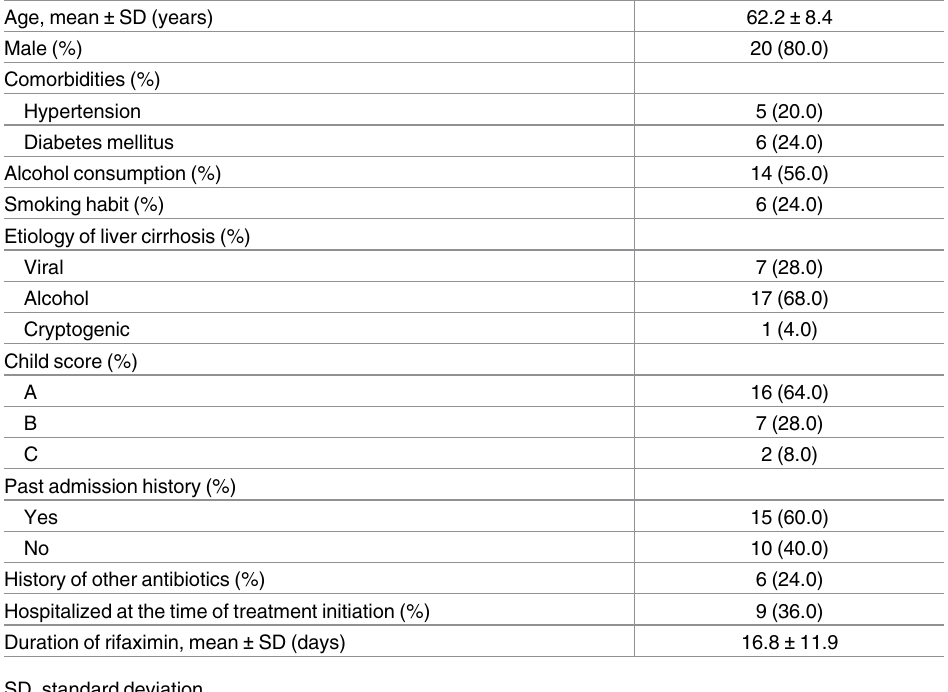
Table 1. Baseline characteristics of the enrolled